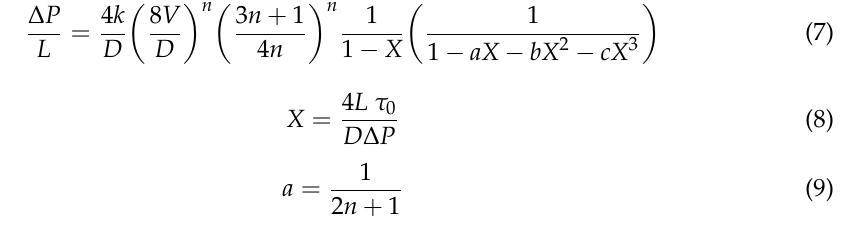
Table 1. Regression functions for viscosity change with a varying shear rate of different viscoelas- tic type1 fluids at Temperature 25 °C.